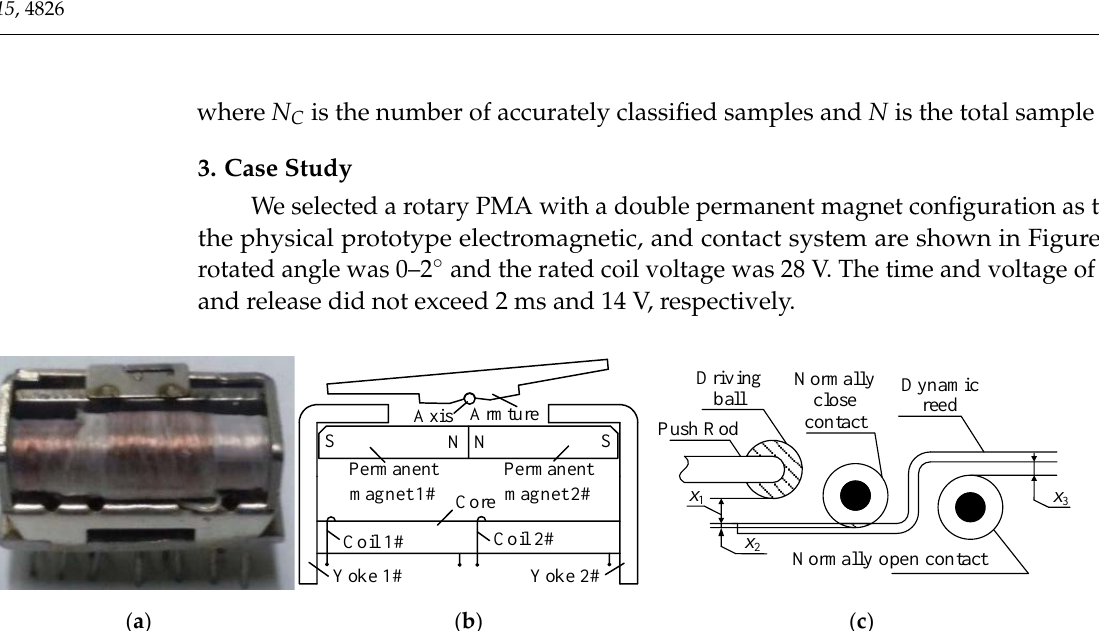
( b ) Figure 11. The simulation results of the rotary PMA: ( a ) coil voltage; ( b ) dynamic suction and release output characteristics. According to the comparison of the simulation results of the coil voltage during the PMA suction with the measured results, the error between the measured and simulated values was within 5%, which verified the accuracy of the simulation model. Based on the working principle and simulation results of the PMA, there were six main manufacturing process parameters for the PMA. The parameter names, central val- ues, and variances are shown in Table 3. Table 3. Critical MP parameters. Parameter